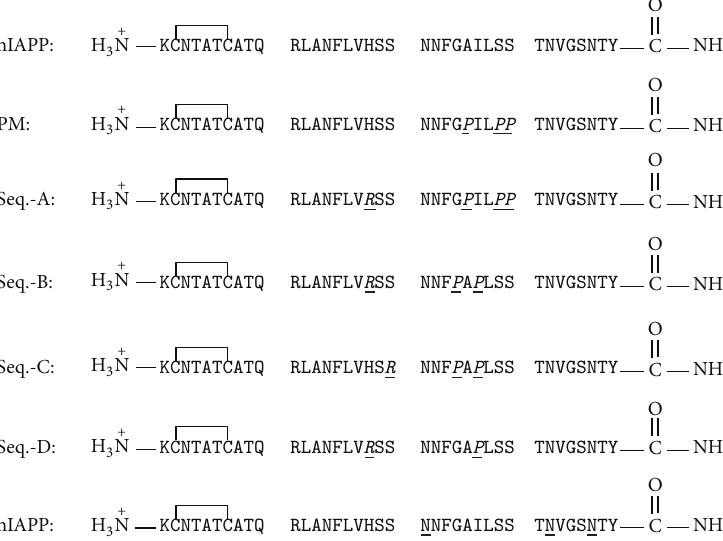
Figure 4: Primary sequences of human IAPP, Pramlintide, and four rationally designed sequences with improved solubility, denoted by Seq- A through Seq-D. The final sequence, denoted by hIAPP ∗ , represents a family of designed bioactive analogs of human IAPP in which one of the Asn residues indicated with a ( ∗ ) has been